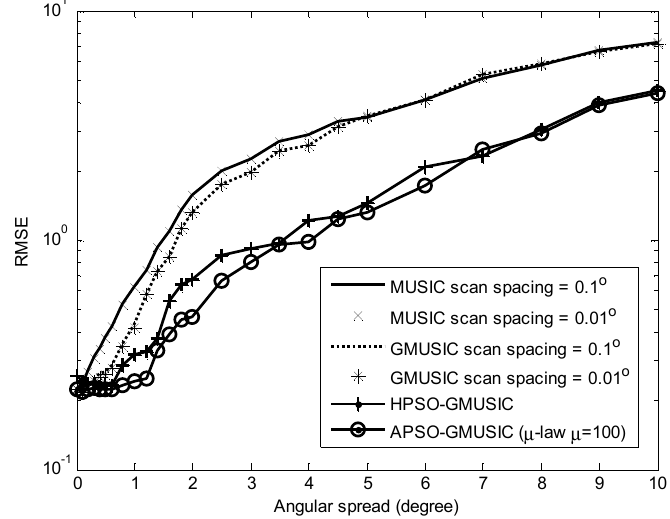
Figure 5. RMSE of DOA estimation versus angular spread.